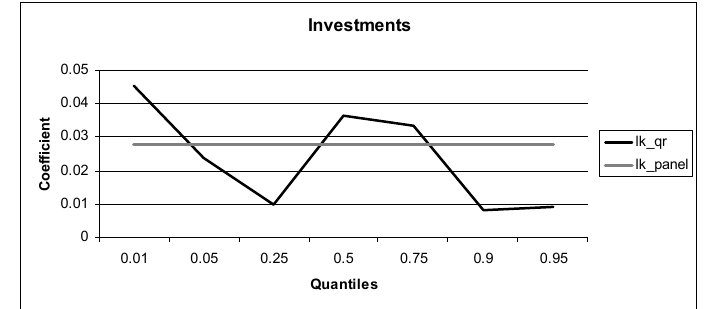
Figure 3 – Quantile Regressions versus Panel Regression estimates: Physical Capital.